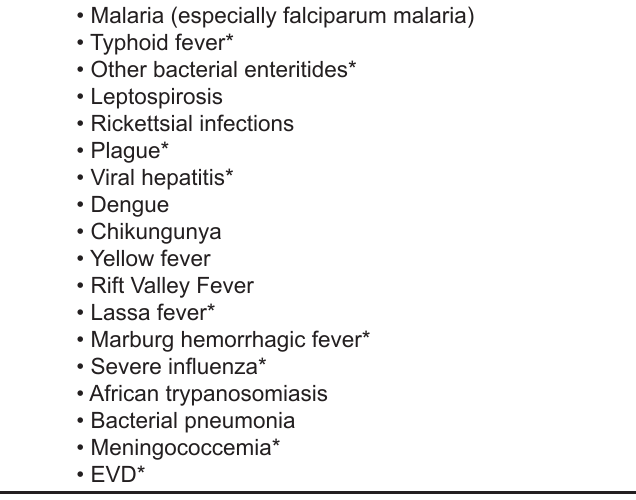
Figure 1. Differential diagnosis of the febrile traveler. EVD , Ebola virus